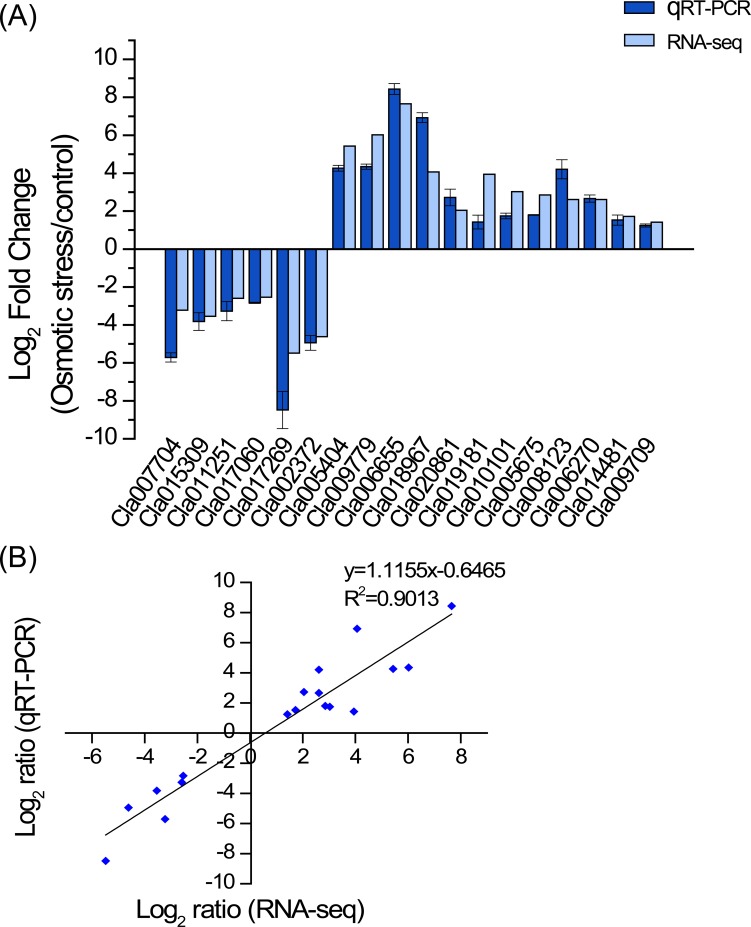
Confirming of transcriptome sequencing data by qRT-PCR.(A) Comparison of gene expression ratios of eighteen genes between transcriptome sequencing and qRT-PCR. (B) Correlation analysis between data of RNA-seq (x axis) and qRT-PCR (y axis).